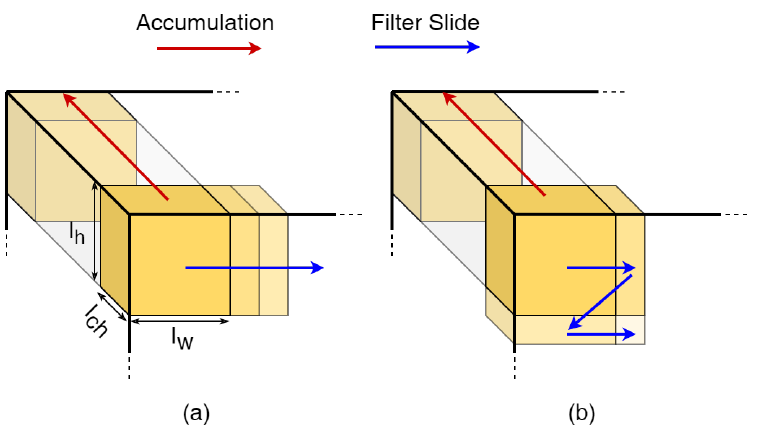
Figure 1. ( a ) Scheduling algorithm in absence of max pooling layers; ( b ) scheduling algorithm in the presence of 2 × 2 max pooling layer.